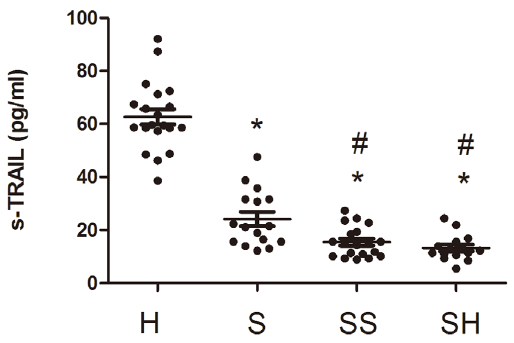
Figure 1. Plasma TRAIL levels in septic patients and healthy controls. *compared with healthy controls, P , 0.01; # compared with the sepsis group, P , 0.05. H: healthy control; S: sepsis; SS: severe sepsis; SH: septic shock.